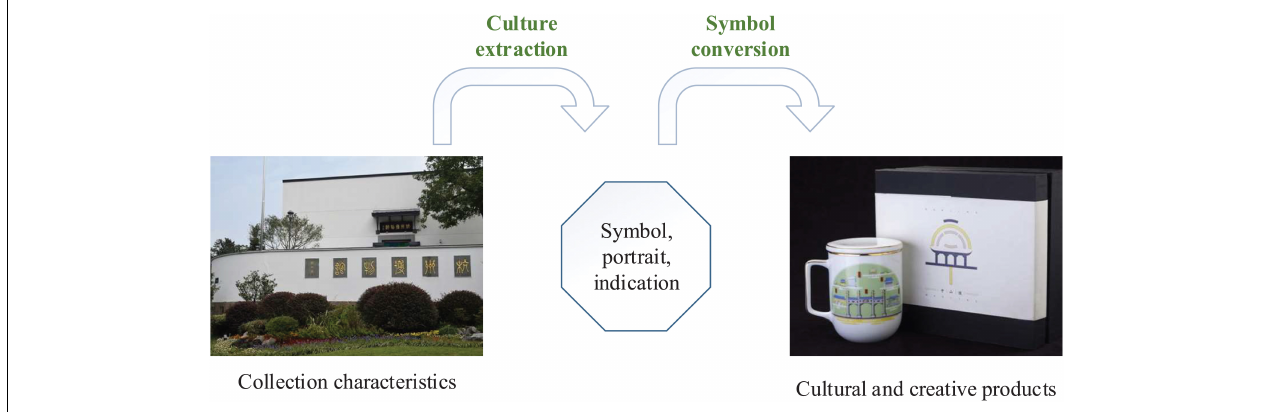
FIGURE 2 | Design transformation process of cultural and creative products. Images reproduced with permission from Suzhou